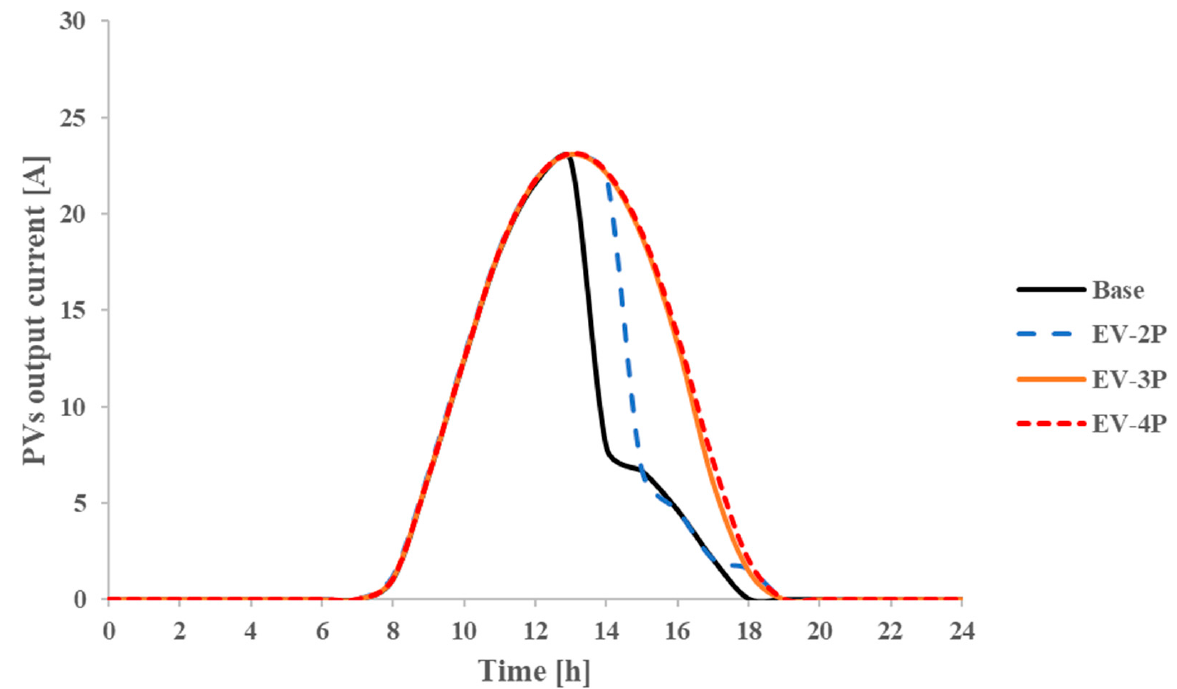
Figure 11. Second life battery SoC for different scenarios at various times during the day.